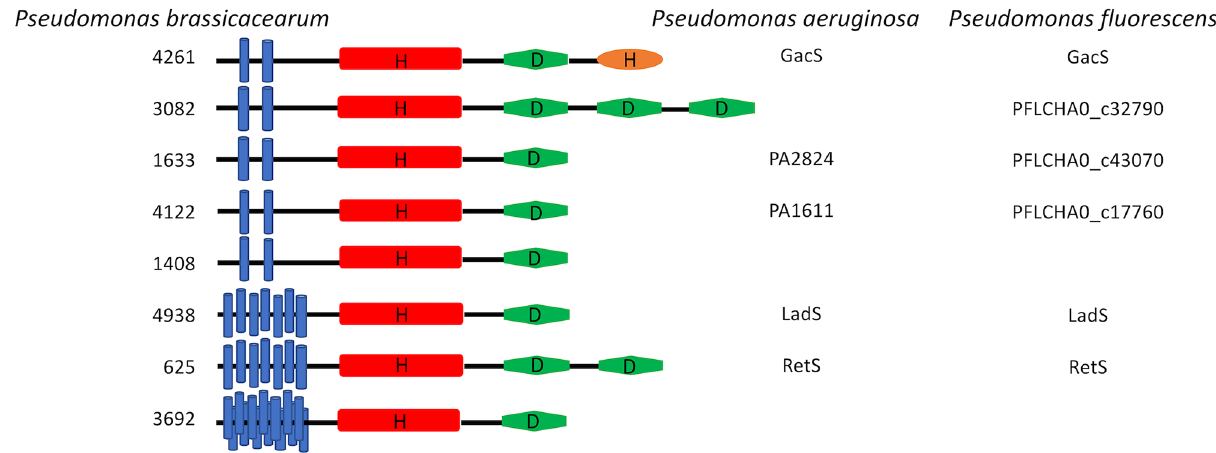
Figure 2. Schematic representation of the conserved domains of each hybrid sensor kinase belonging to the ‘GacS cluster’. Homologues of the P. brassicacearum hybrid HKs, found in the P. aeruginosa and P. fluorescens genomes, are specified. Kinase domain (red), receiver domain (green), HPt domain (orange), transmembrane segment (blue). Histidine (H) and aspartate (D) indicate phosphorylation